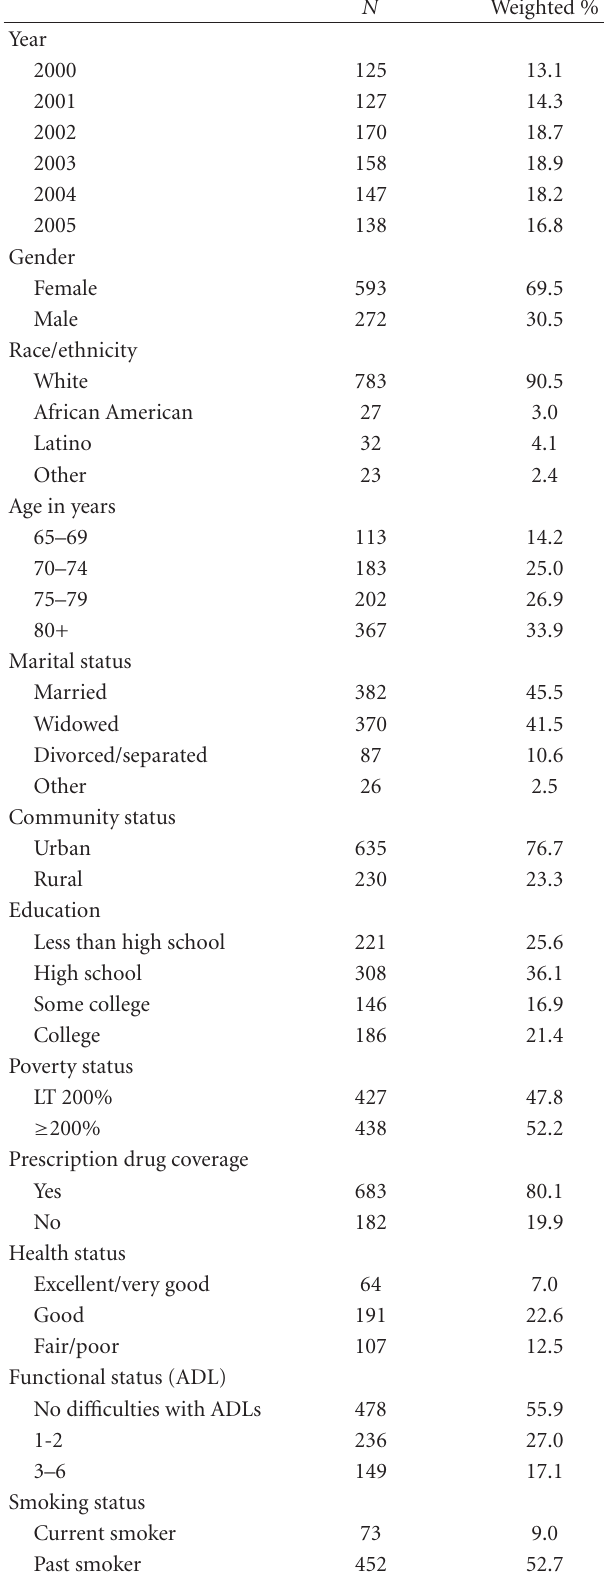
Table 1: Description of study sample with reported cancer